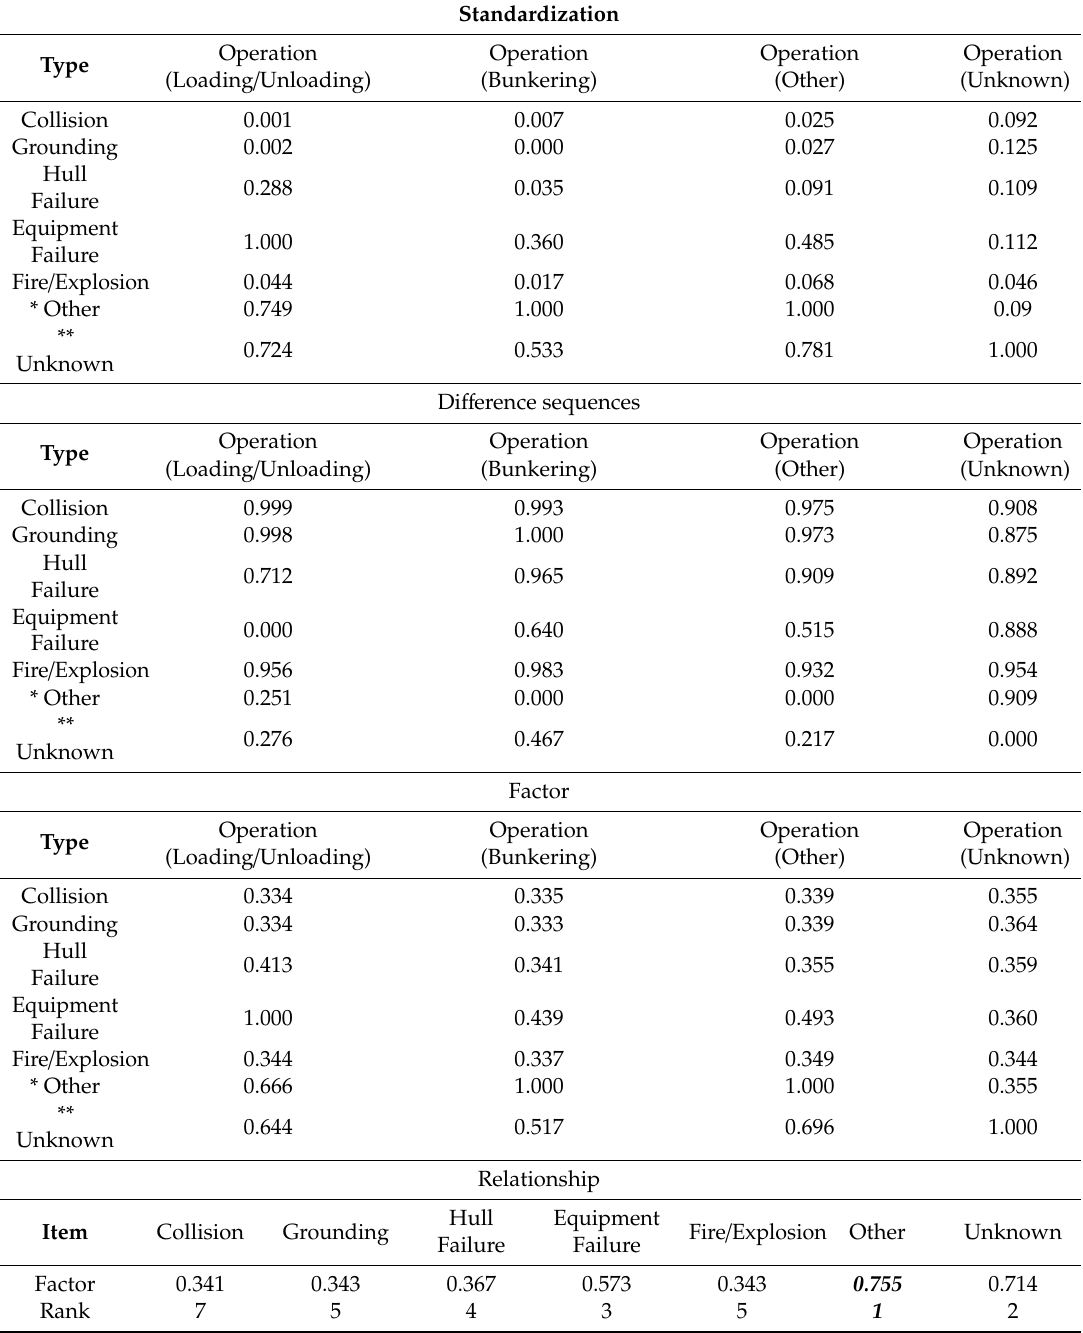
Table A3. Statistical analysis of oil spills of less than 7 tons from 1974 to 2012.